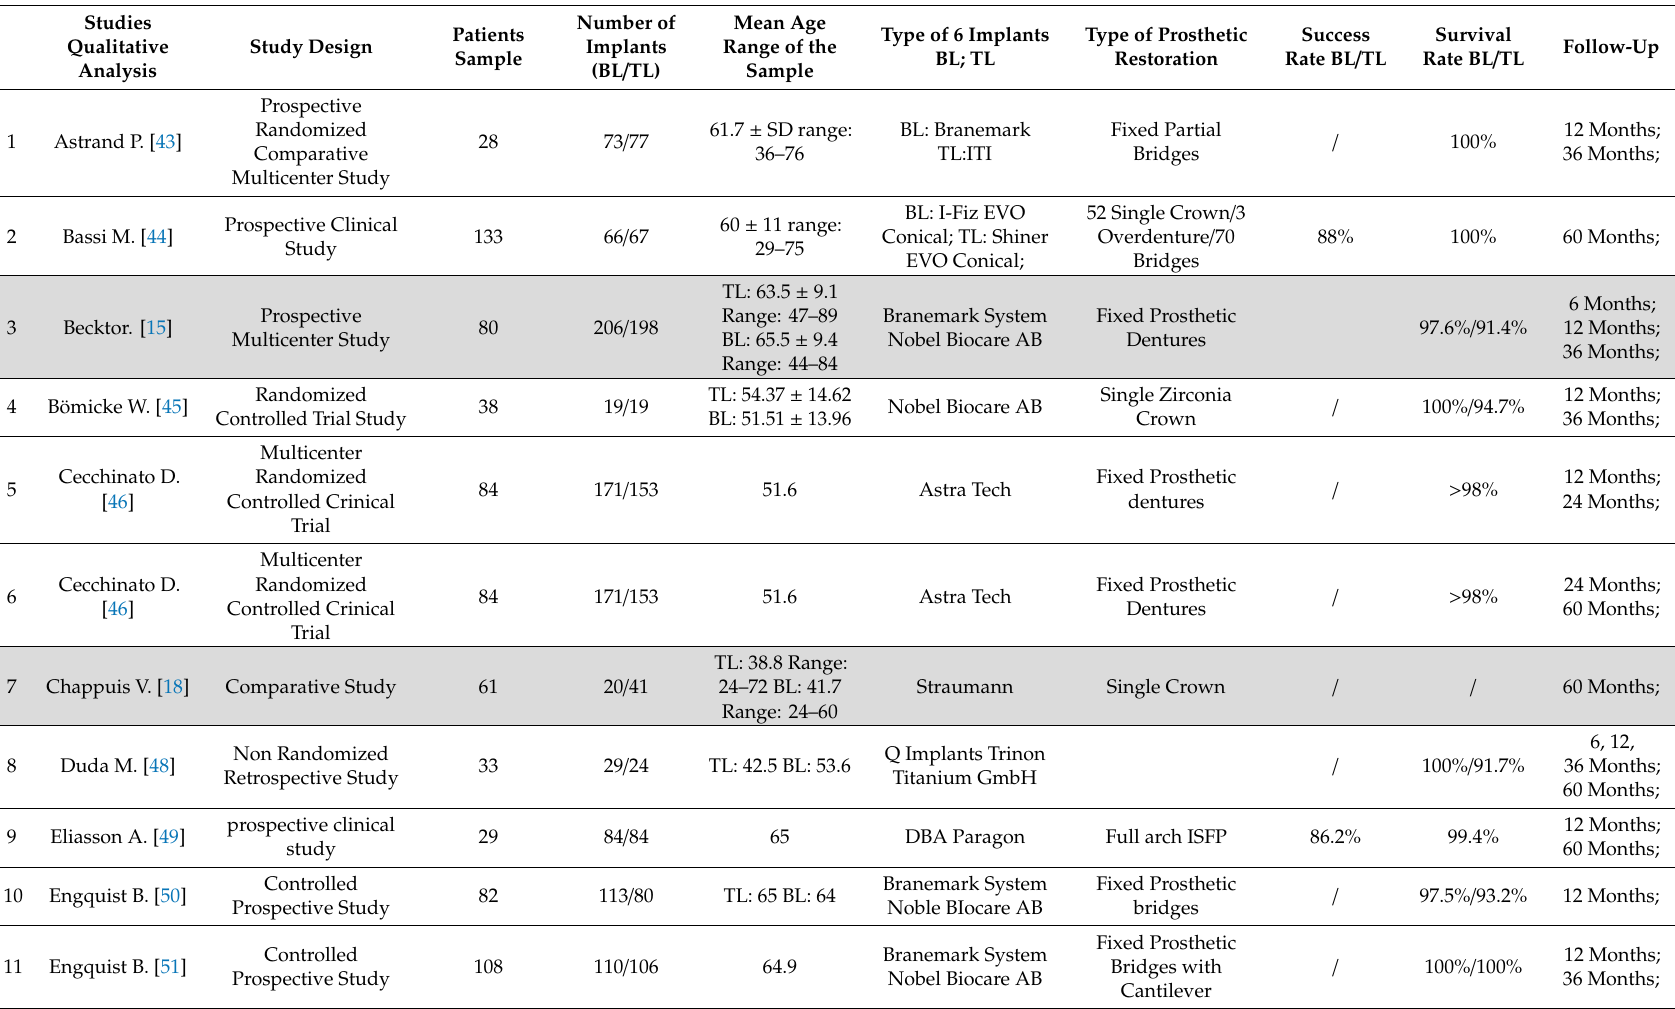
Table 2. All studies included for the qualitative analysis. The 3 studies in grey rowed were excluded from the quantitative analysis as explained in the text [43–59]. Studies Qualitative